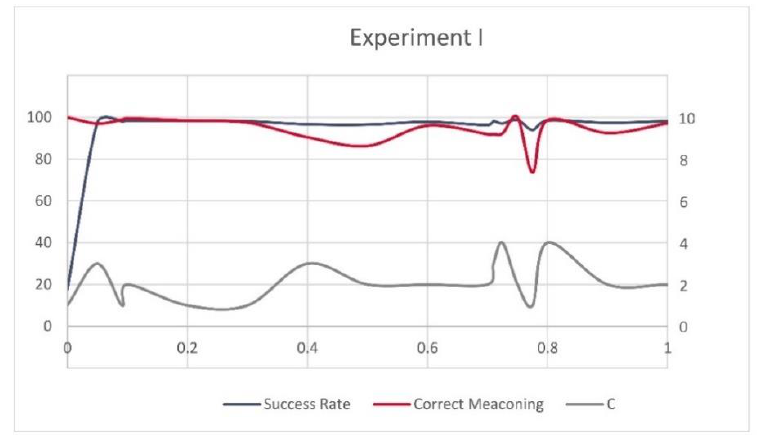
Figure 13. Success rate, correctly recognized meaconing records and C for Experiment I.